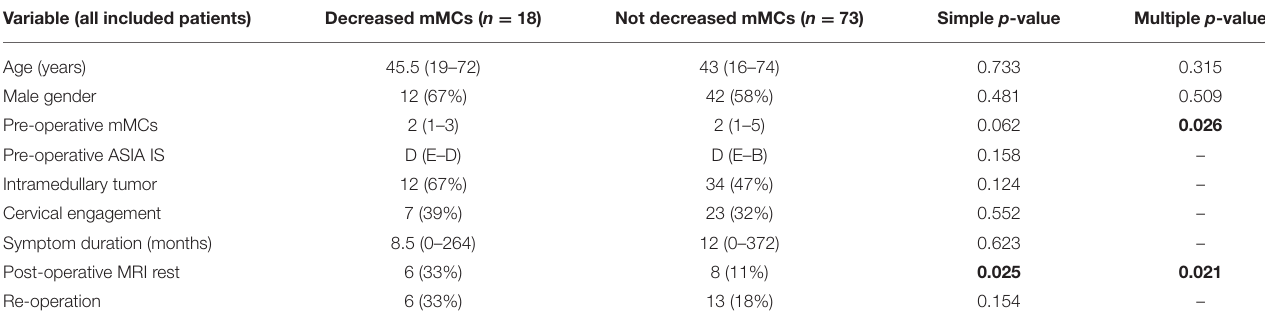
TABLE 6 | Predictors of decreased long-term functional outcome following resection of intra- and juxtamedullary spinal tumors. Variable (all included patients)